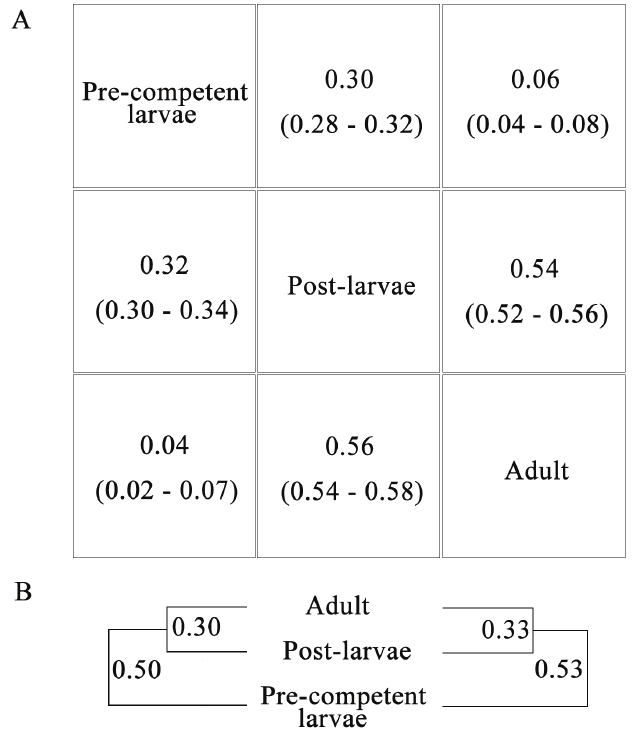
Figure 8. Comparing the results of the first and second gene expression analyses with the original and normalized datasets of raw reads for the three life cycle stages. In the read normalization assessment, the two larger datasets for the pre-competent larvae and adult are reduced in size by random subsampling to equal that of the smallest post-larvae sample (Table 1). The first and second gene expression analyses are then repeated. ( A ) Pearson’s r s {with confidence intervals (CIs) in parentheses} for the first gene expression analyses with the original and normalized datasets (below and above the diagonal, respectively; the former correlations are from Figure 5A); ( B ) Dendrograms { i.e. , unweighted pair-group method with arithmetic means (UPGMA) with distance = (1 (cid:4) r )} for the second gene expression analyses with the original and normalized datasets (left and right, respectively; the former tree is from Figure